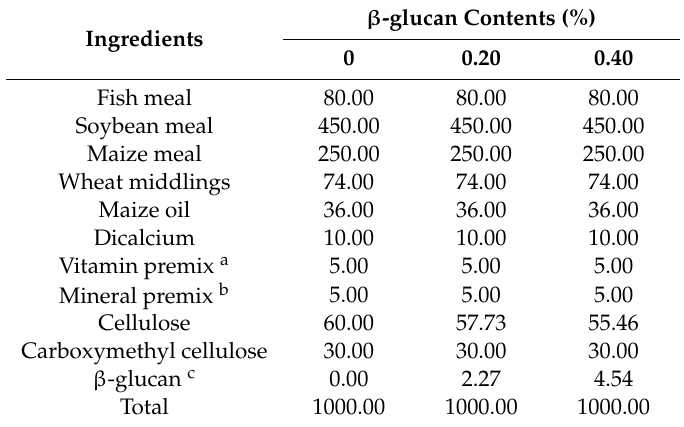
Table 1. Ingredient formulation (g / kg dry basis) of three experimental diets fed to Oreochromis